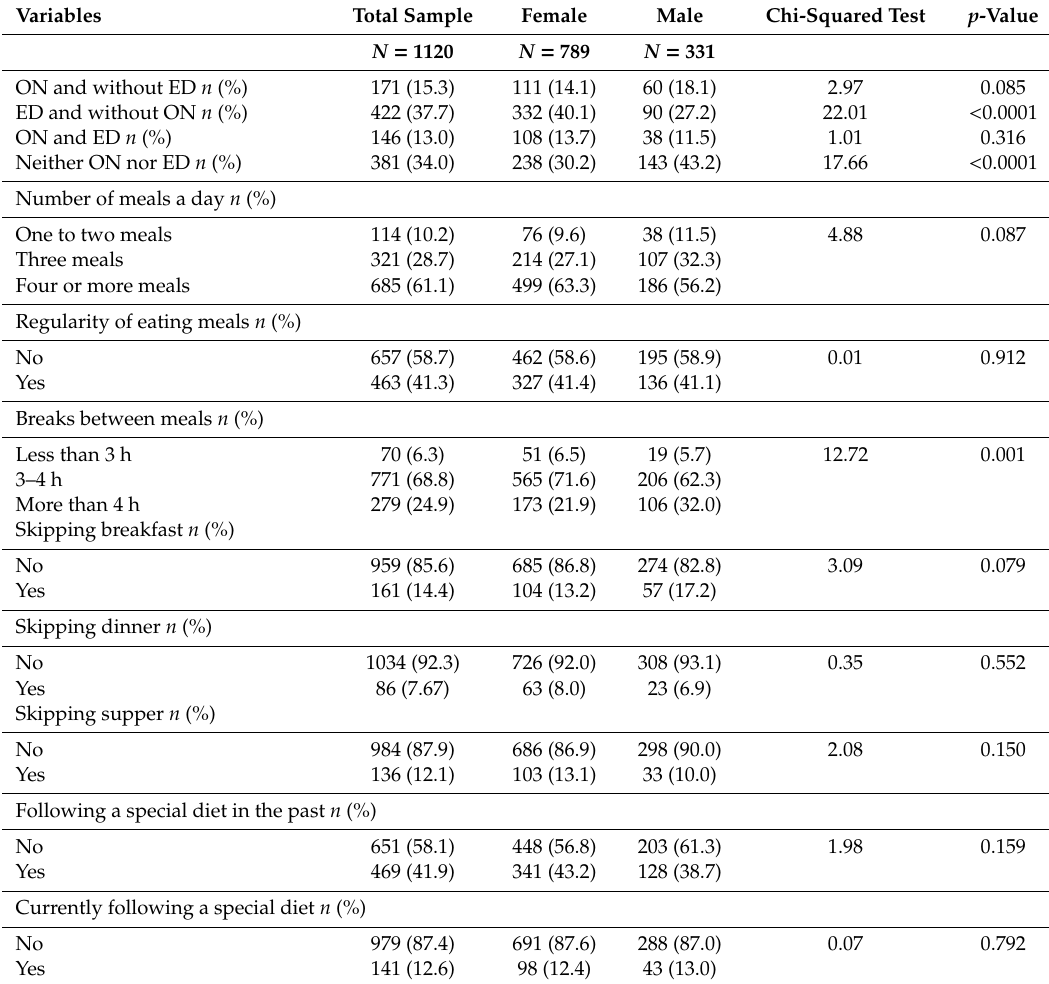
Table 3. Orthorexia nervosa tendency, eating disorders symptoms, and eating habits in the total sample and gender